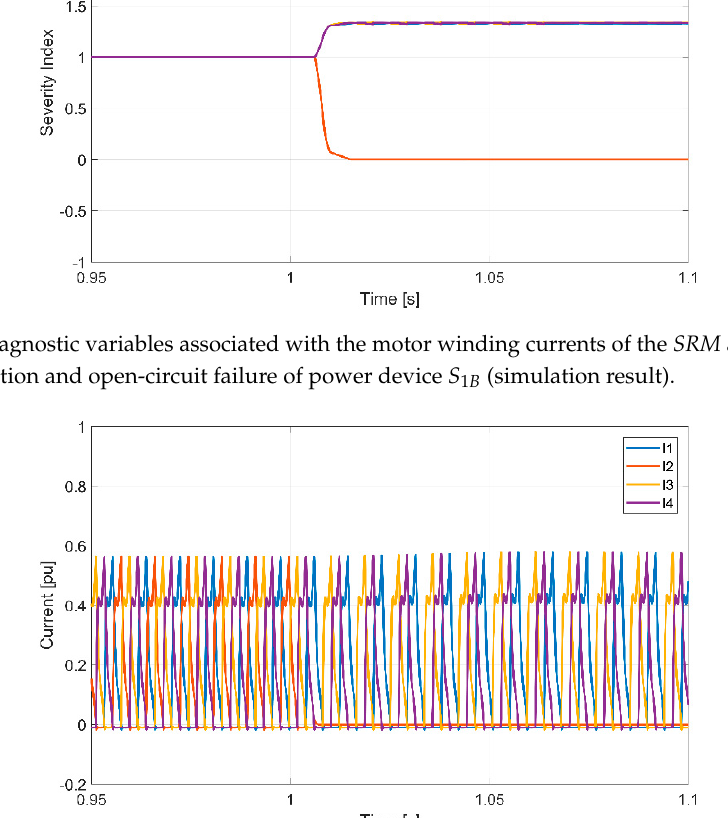
Figure 13. Diagnostic variables associated with the motor winding currents of the SRM at 2850 rpm in normal condition and open-circuit failure of power device S 1 C (simulation result). Simulation tests for a different fault, more specifically for short-circuit failure, were also performed. The first tests, considering this failure mode, were performed for low speed, more specifically at 60 rpm and 600 rpm. Thus, for both tests, initially, the motor was operated at normal condition and a short-circuit failure was introduced at t = 1 s in the power semiconductors S 1 A and S 1 C (for the 60 rpm and 600 rpm respectively). The obtained winding currents for both tests can be seen in Figure 14. As expected, in normal operation the winding currents are controlled and balanced. However, after the fault, the current in the winding connected to the faulty bridge leg will increase to very high values. The behavior of the correspondent diagnostic variables, considering this failure mode, can be seen in Figure 15. Through these results, it is possible to verify that in normal condition all the variables are stable at the value of one. However, after this failure mode the variable associated with the faulty leg changes, increasing for higher values (2 and 2.9 for 60 rpm and 600 rpm). The other variables will also change their values, but in an opposed way (less than 1). Analysing these values and the values presented in Table 1 (for a failure in a different power device), it is possible to confirm similar results.